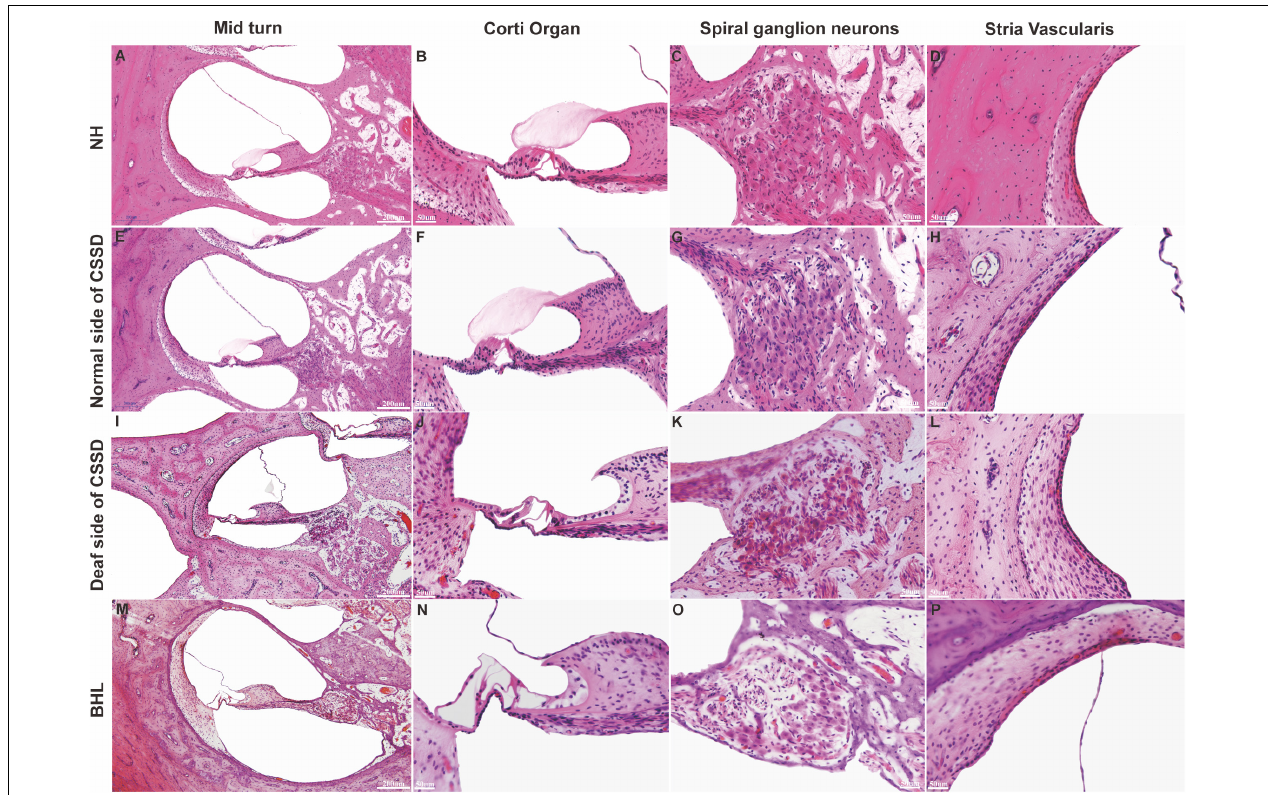
FIGURE 5 | Celloidin embedding–hematoxylin–eosin (CE-HE) results of each phenotype at P8 in congenital single-sided deafness (CSSD) pedigree. Panels (A,E,I,M) were at low magnification (10 × ). The other images are all high magnification (40 × ). Panels (B , F , J , N) showed fine structure of the organ of Corti; panels (J,N) showed loss of hair cells in the deaf side of CSSD and bilateral hearing loss (BHL) individuals. Panels (C , G , K , O) showed the changes in spiral ganglion cells. Panels (D , H , L , P) showed the fine structure of stria vascularis of each phenotype in CSSD